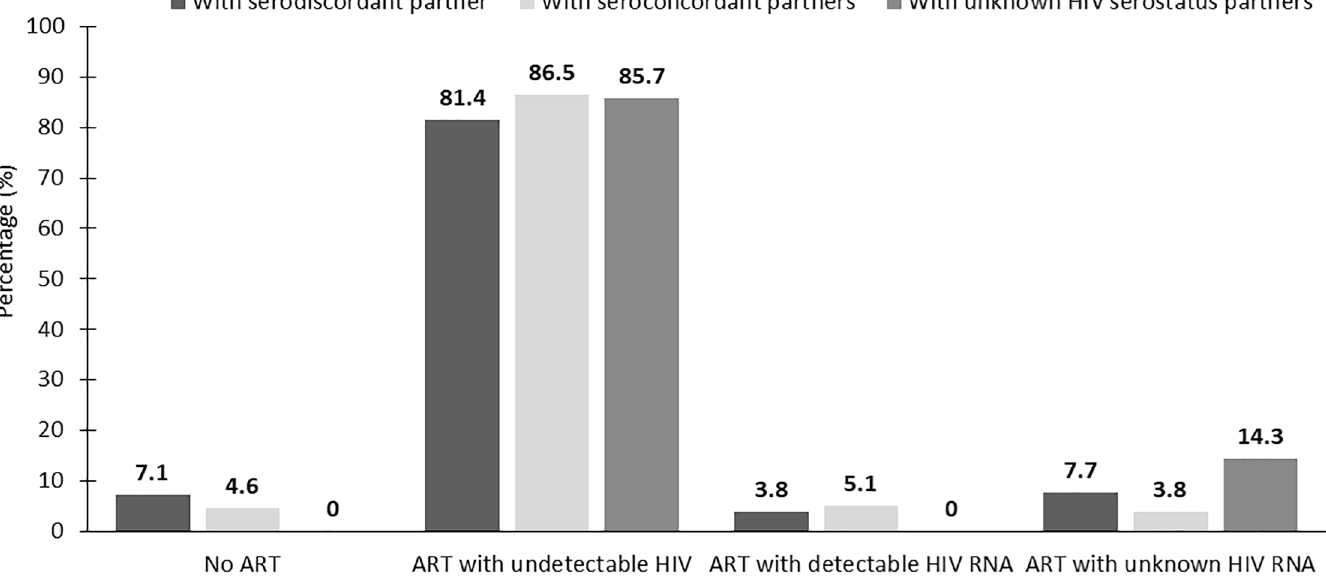
Fig 3. Proportion receiving antiretroviral therapy and outcomes of the index HIV-infected patients with serodiscordant, seroconcordant, and unknown HIV serostatus partners.